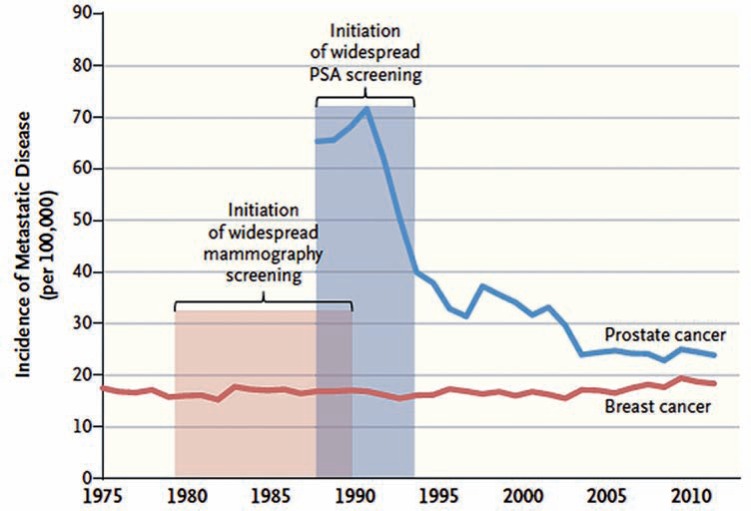
incidence of metastatic cancer at diagnosis, USA, 1975-2012.